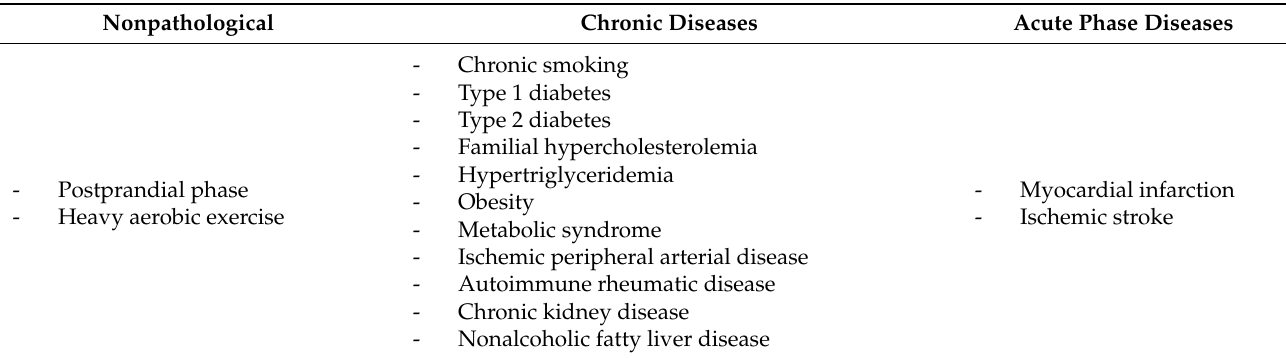
Table 1. Situations with increased LDL( − )